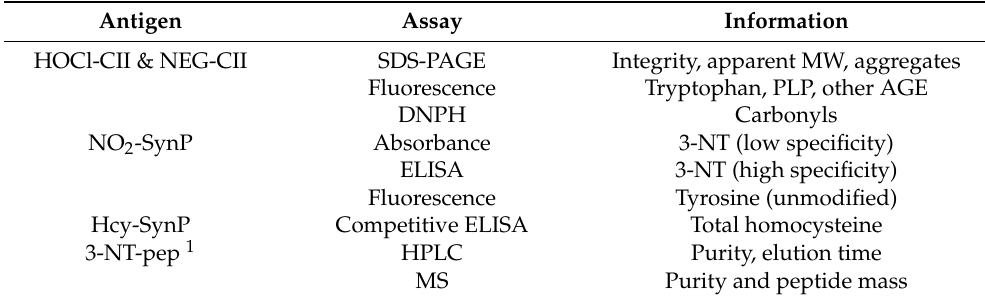
Table A1. Techniques used for verification of the four